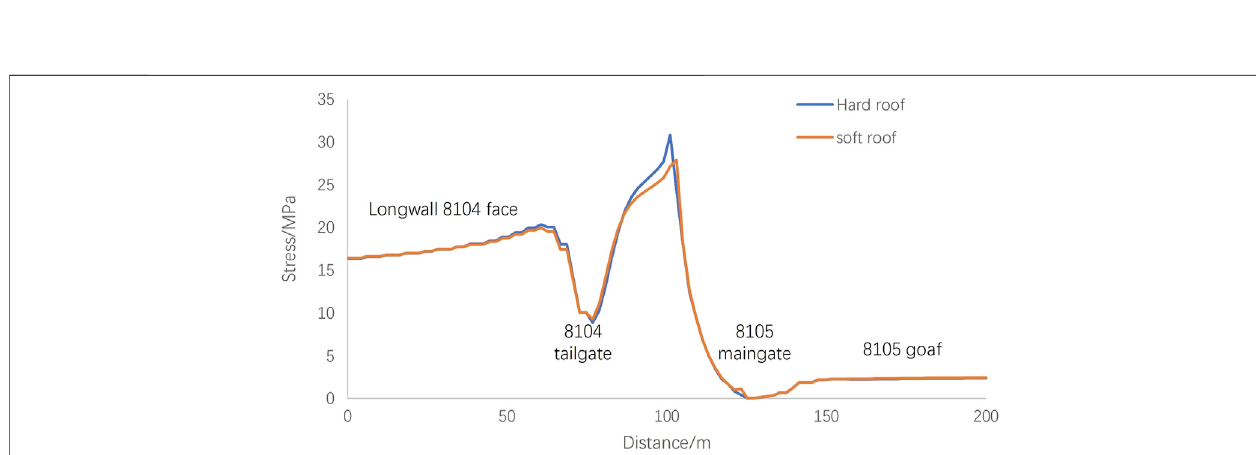
FIGURE 8 | Vertical stress curves in the pillar after the fi rst face was excavated.